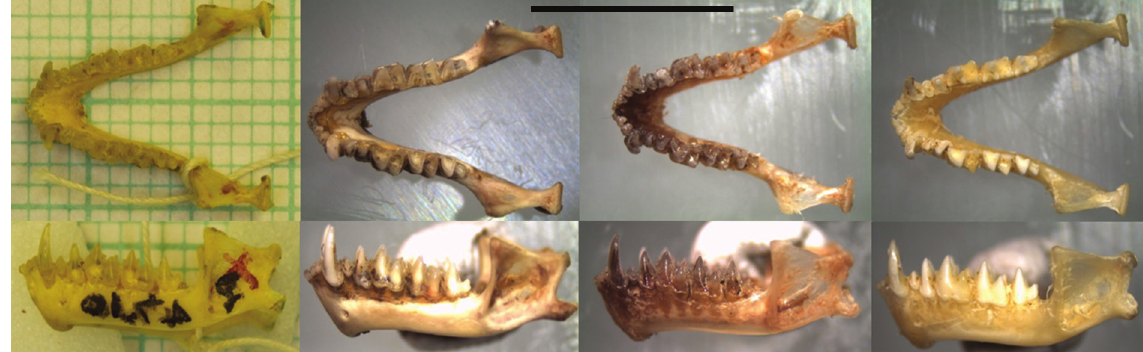
Fig. 6. Mandibles of the four known specimens of Glauconycteris superba Hayman, 1939 (upper row: dorsal view, lower row: lateral view). From left to right: holotype of G. s. sheila Hayman, 1947 (BMNH 47.10, ♀) [lateral picture flipped to fit the orientation of the other pictures], holotype of G. superba (RMCA 14765, ?), new specimen from Mbiye Island (RMCA a1.097-M-3153, ♂), and the specimen from Matonguiné (RMCA 97.077-M-7719, ♂). Scale bar = 1